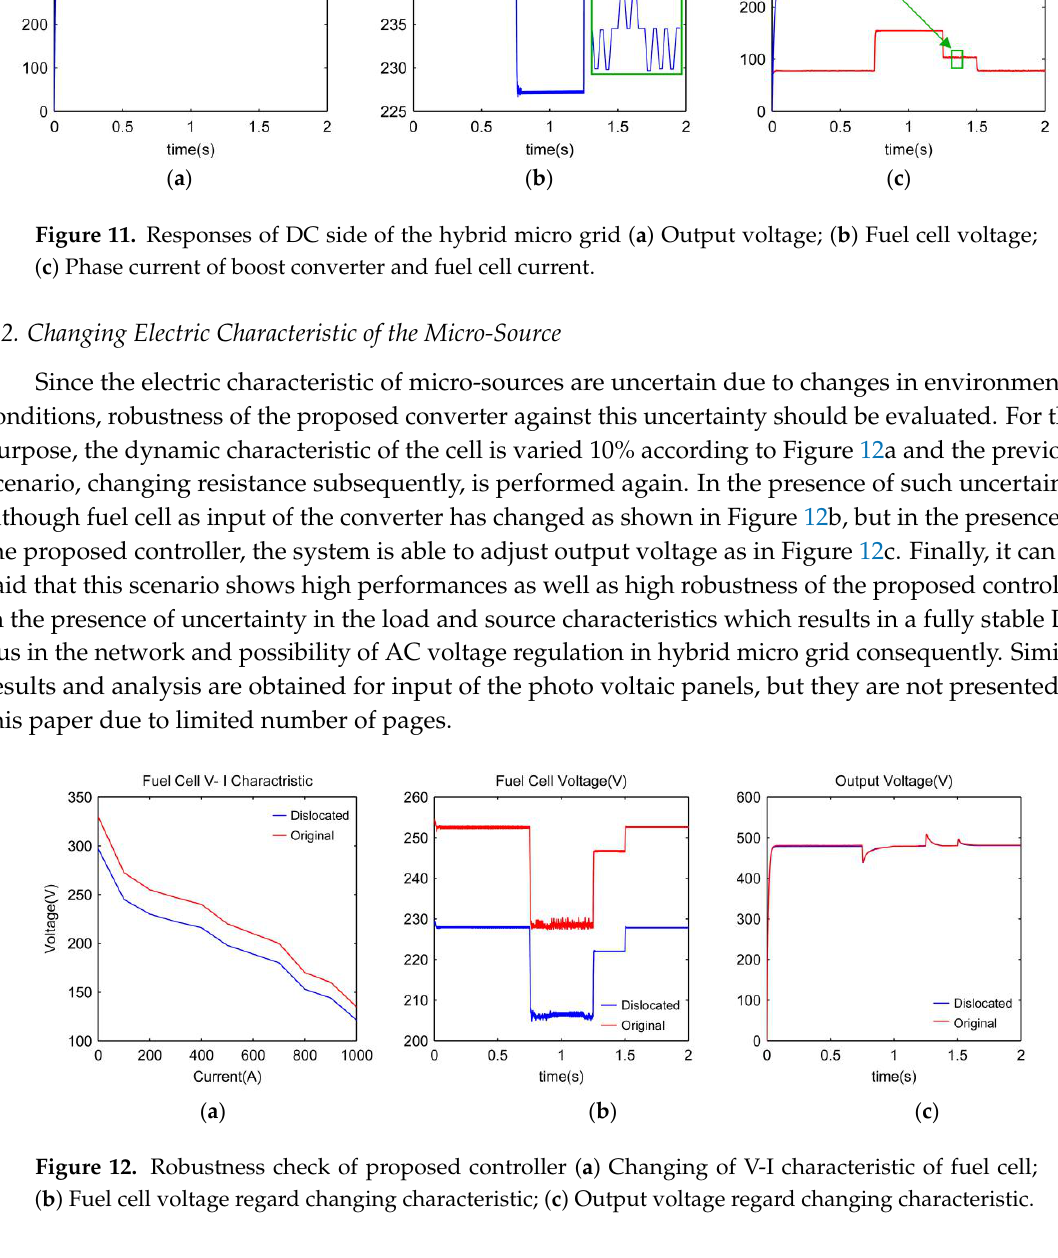
Figure 10. ( a ) Variation of DC load resistance; ( b ) Estimation of load conductance; ( c ) Duty cycle of switches created by proposed controller.